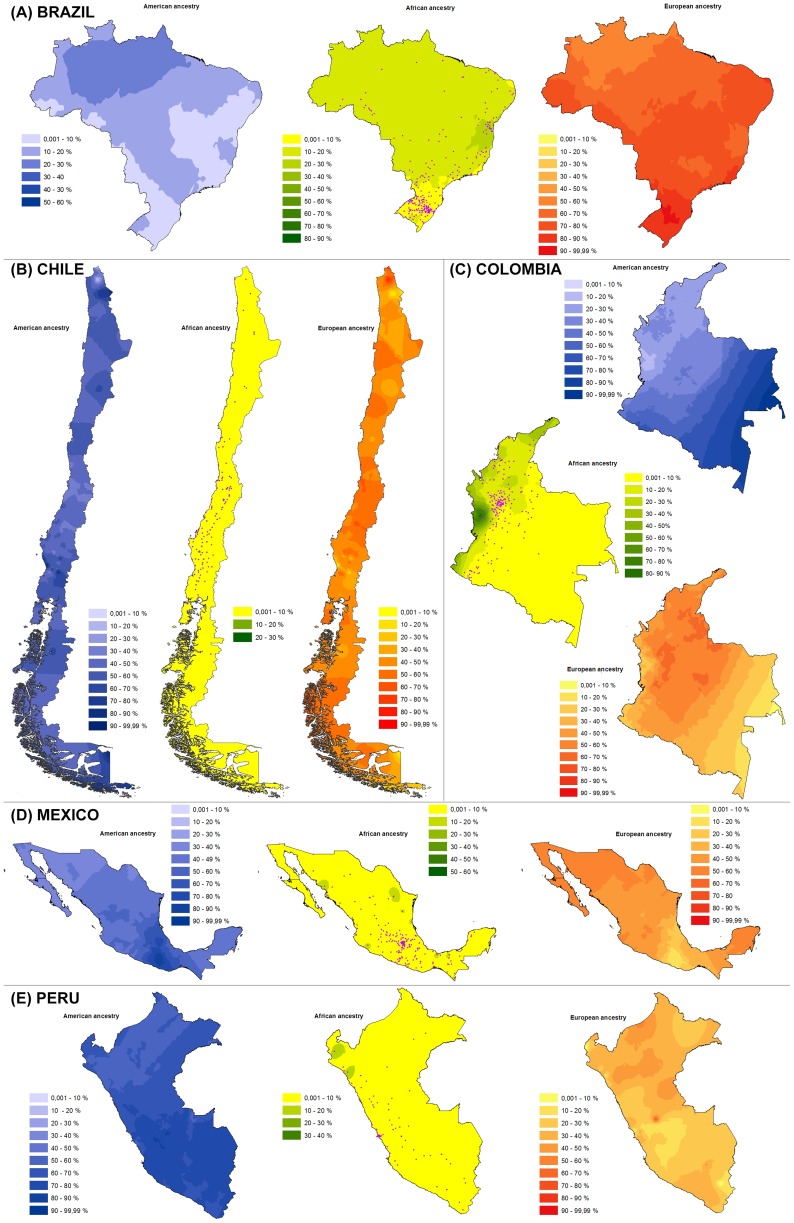
Geographic distribution of Native American (blue), African (green) and European (red) ancestry based on individual estimates for samples from (A) Brazil, (B) Chile, (C) Colombia, (D) México and (E) Perú.To facilitate comparison, color intensity transitions occur at 10% ancestry intervals for all maps. The birthplace of individuals are indicated by purple dots on the African ancestry map. Sampling density is shown in Figure S4. Maps were obtained using Kriging interpolation as detailed in the text.